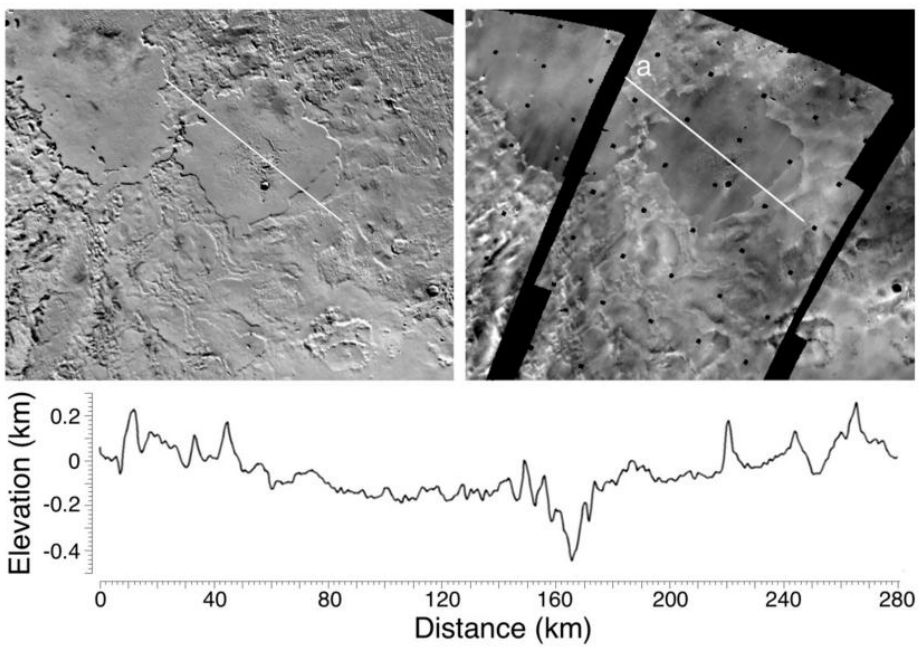
Figure 13. Topographic profile across the margin and central pits of the walled Ruach Planitia. Subtle undulations on the floor of the walled plains are within the stereoscopic uncertainty limits of the SG-DEM and might not be real. ( top ) Image mosaic and ( right ) DEM scene width is ~480 km from SG-PC-DEM in Figure